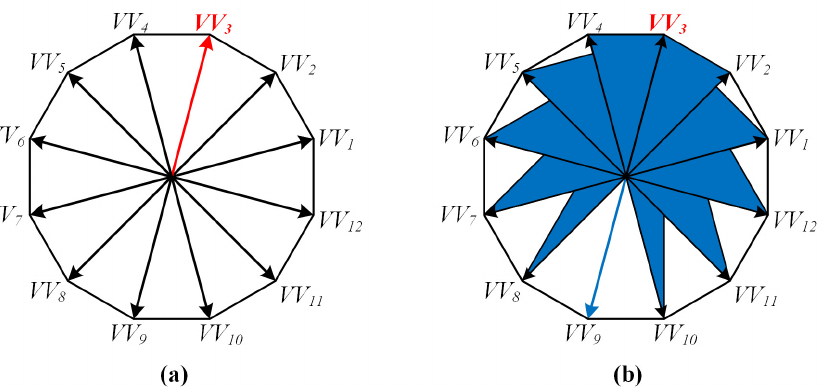
Figure 8. The range of output voltage vector for two methods. ( a ) VV-MPC, ( b ) proposed MVV- MPC.